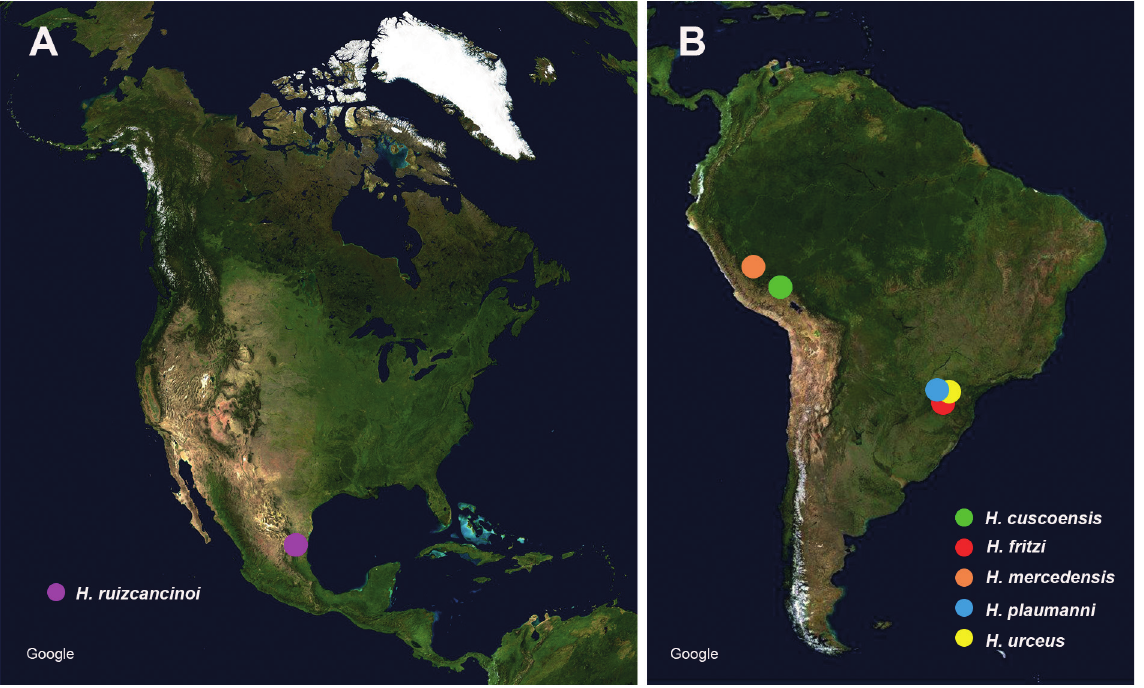
Fig. 9. Distribution of New World species of Handaoia Seyrig, 1952. A . North and Central America. B . South